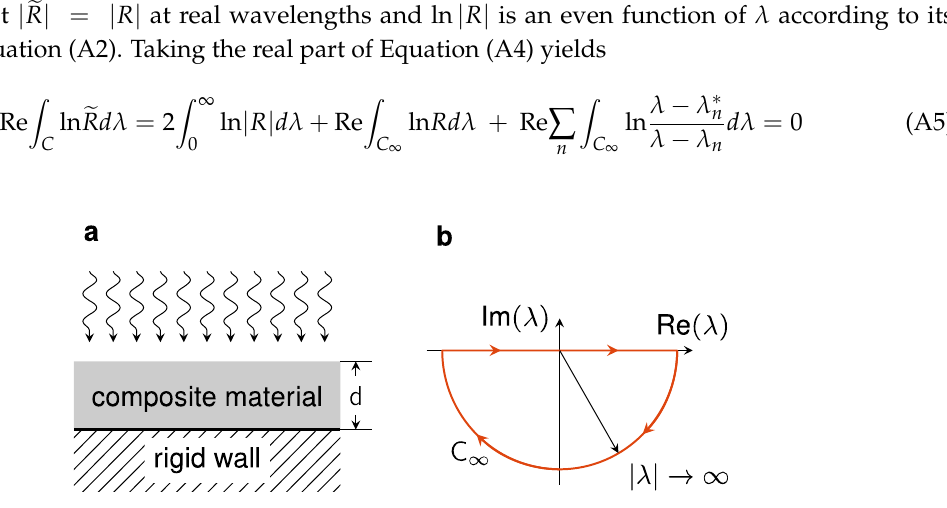
Figure A1. ( a ) Schematic for the geometry of the composite absorbing layer. ( b ) The contour for the integral in Equation (A4).